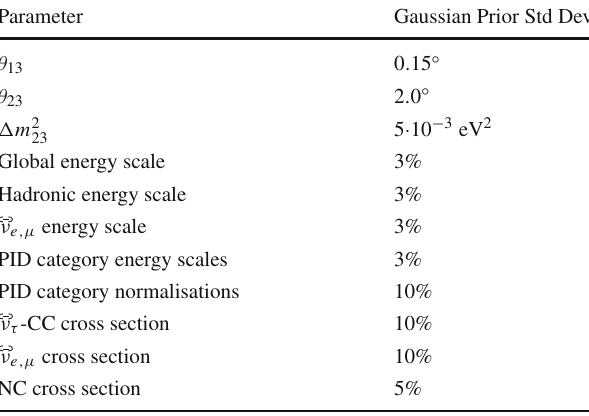
Table 1 Parameters considered as systematic uncertainties together with the standard deviation of the Gaussian priors applied to them Parameter